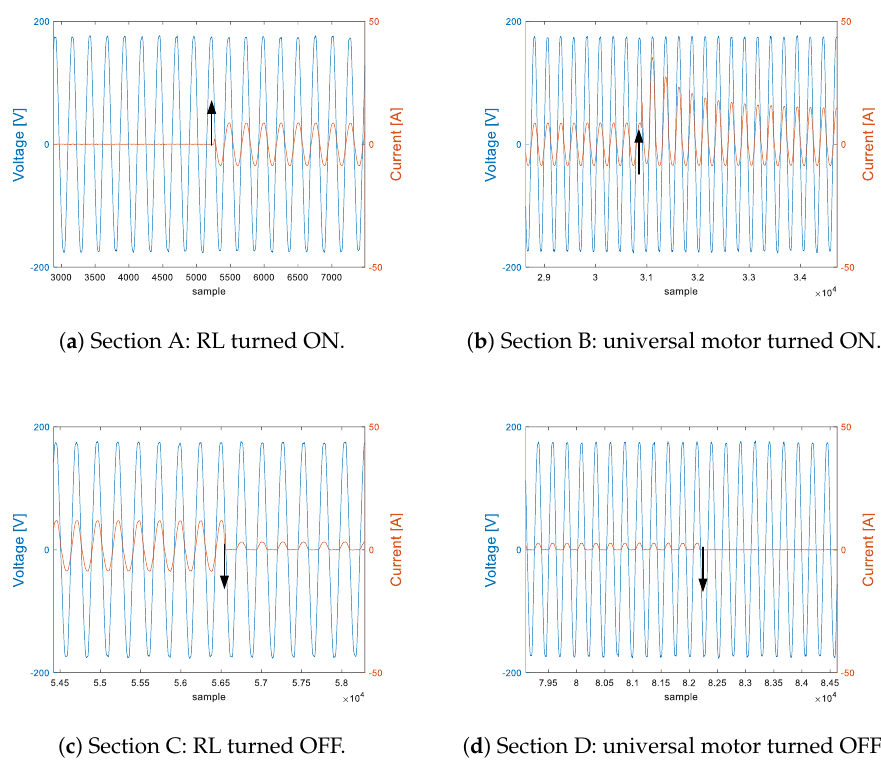
Figure 20. Simulated subset complete acquisition: RL and universal motor. AC mains voltage and current.